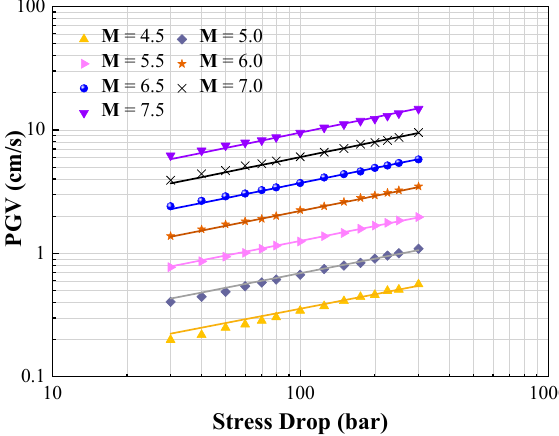
Figure 4. Simulated values of peak ground velocity (PGV) (symbols) alongside predictions by CAM (lines) for varying moment magnitudes (M4.5–M7.5) and stress drops (30–300 bar), at R = 30 km.